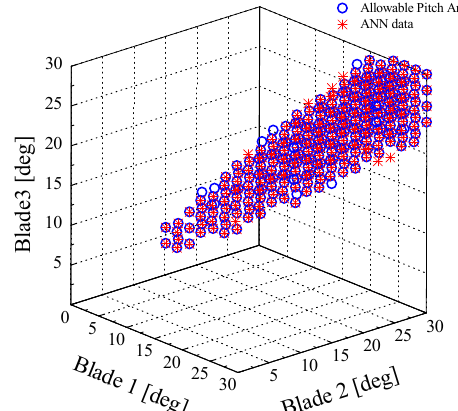
Figure 8. APA and ANN data for M a of 14 m/s.